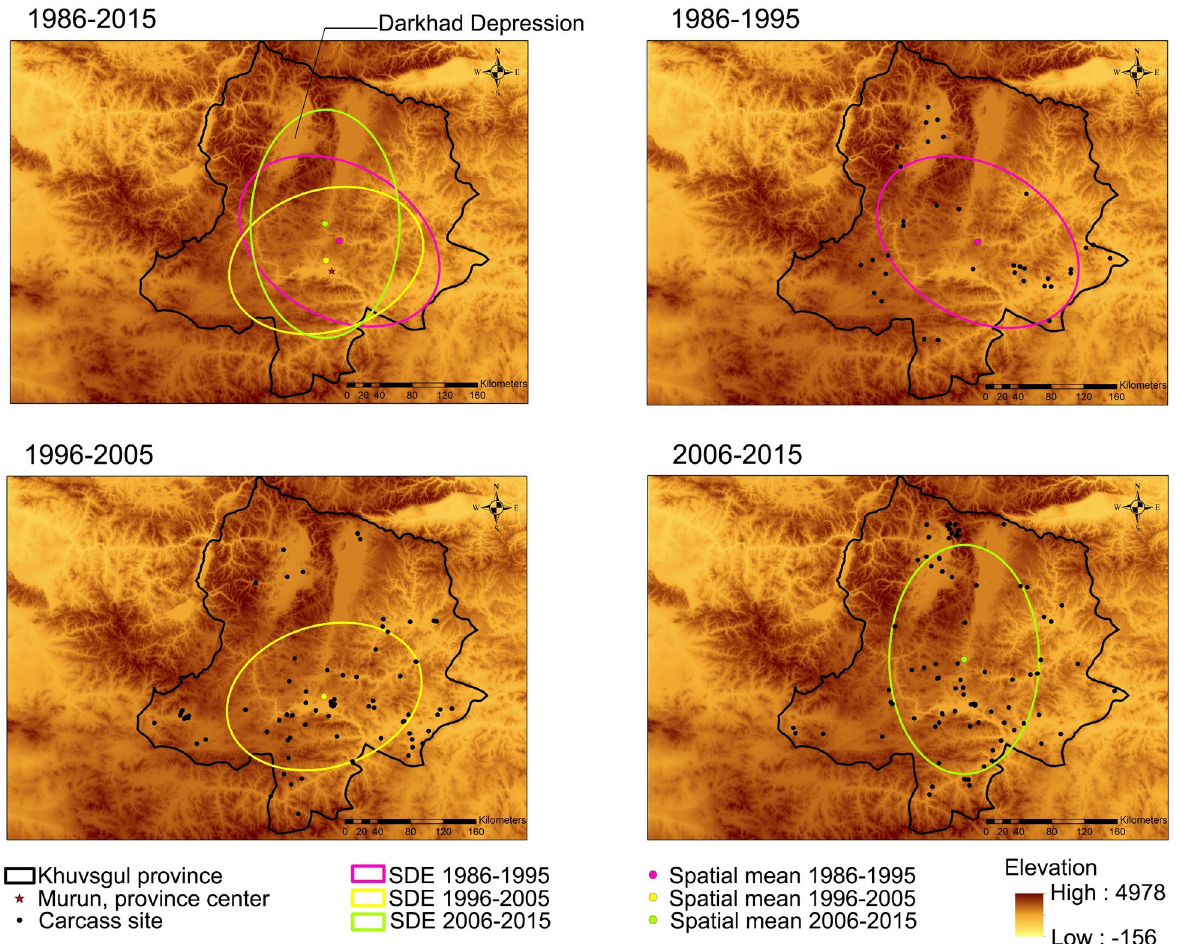
Fig 3. The directional distribution of animal carcass sites registered between 1986 and 2015. Unweighted spatial means and standard deviational ellipse (SDE) were determined in three periods (1986–1995, 1996–2005, and 2006–2015). The unweighted spatial mean centers indicate the average value of carcass locations in the given time phases. Ellipses with mean centers were combined to denote the directional distribution of carcass sites. The base map is the elevation in meters, with lighter areas being lower in elevation. The maps are reprinted from [28] under a CC BY license, with permission from DIVA-GIS and Dr. Robert Hijmans; see S1